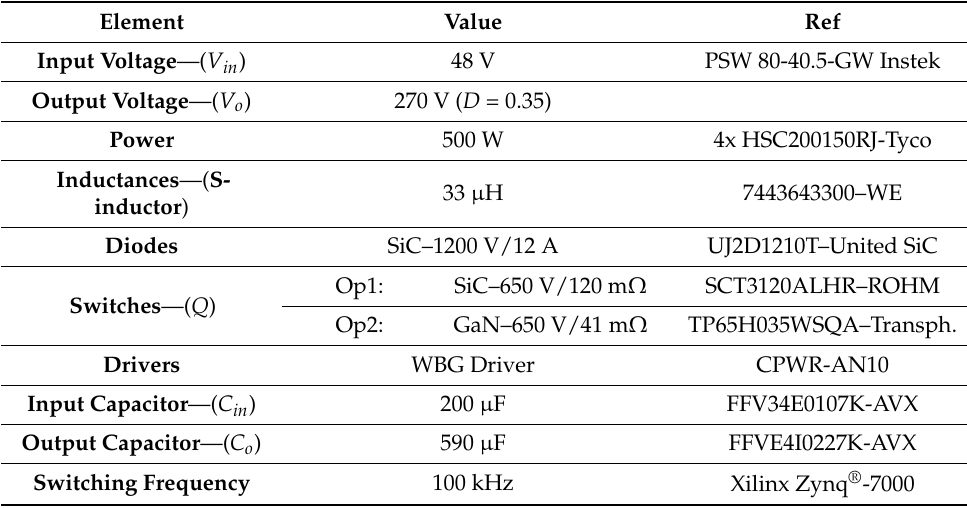
Figure 4. Top and side view of the prototype circuit. Table 1. Parameters and elements selected in the